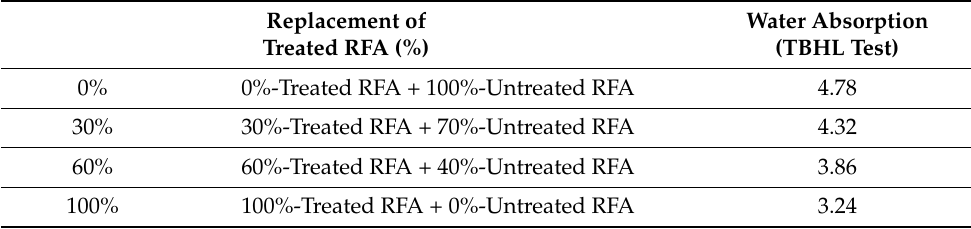
Table 2. Water absorption value for RFA. Table 3. Mix proportion of the mortar made with treated RFA.